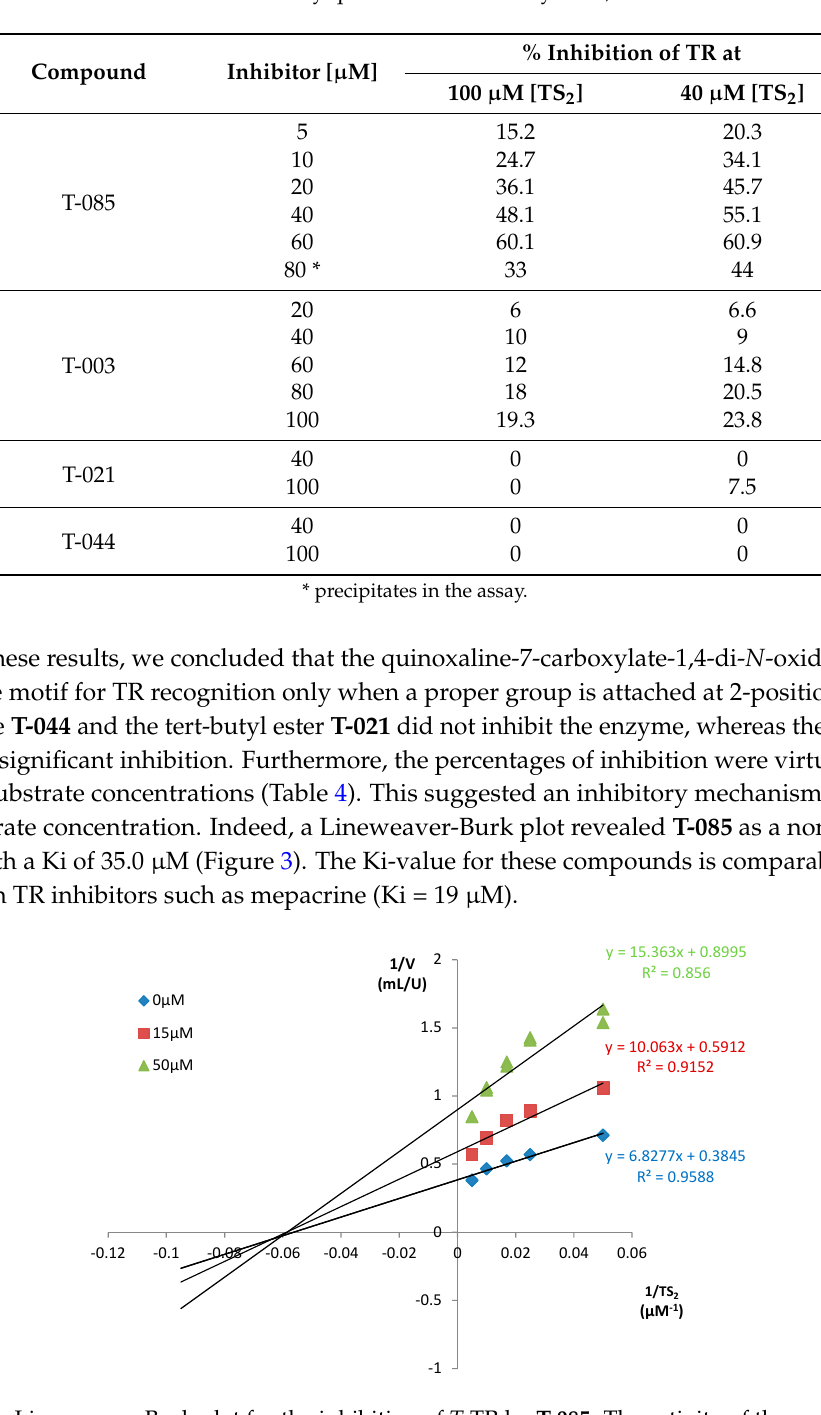
Figure 3. Lineweaver–Burk plot for the inhibition of Tc TR by T-085 . The activity of the enzyme was measured in the absence and presence of two fixed concentrations of inhibitor (15 µ M and 50 µ M) and varying the concentration of the substrate (200 µ M, 100 µ M, 60 µ M, 40 µ M and 20 µ M). The inhibitory constant Ki was calculated from the direct plot using nonlinear least-squares data fitting in an Excel spreadsheet.